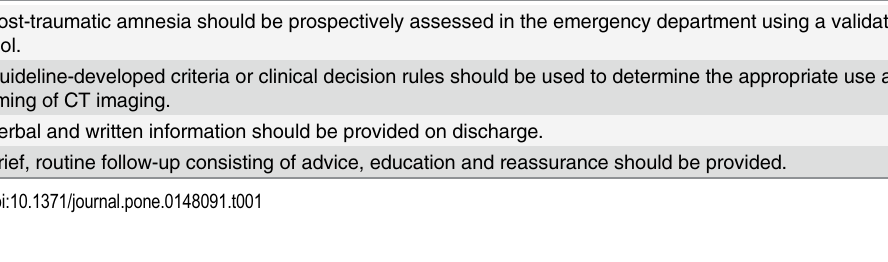
Table 1. Four key recommended